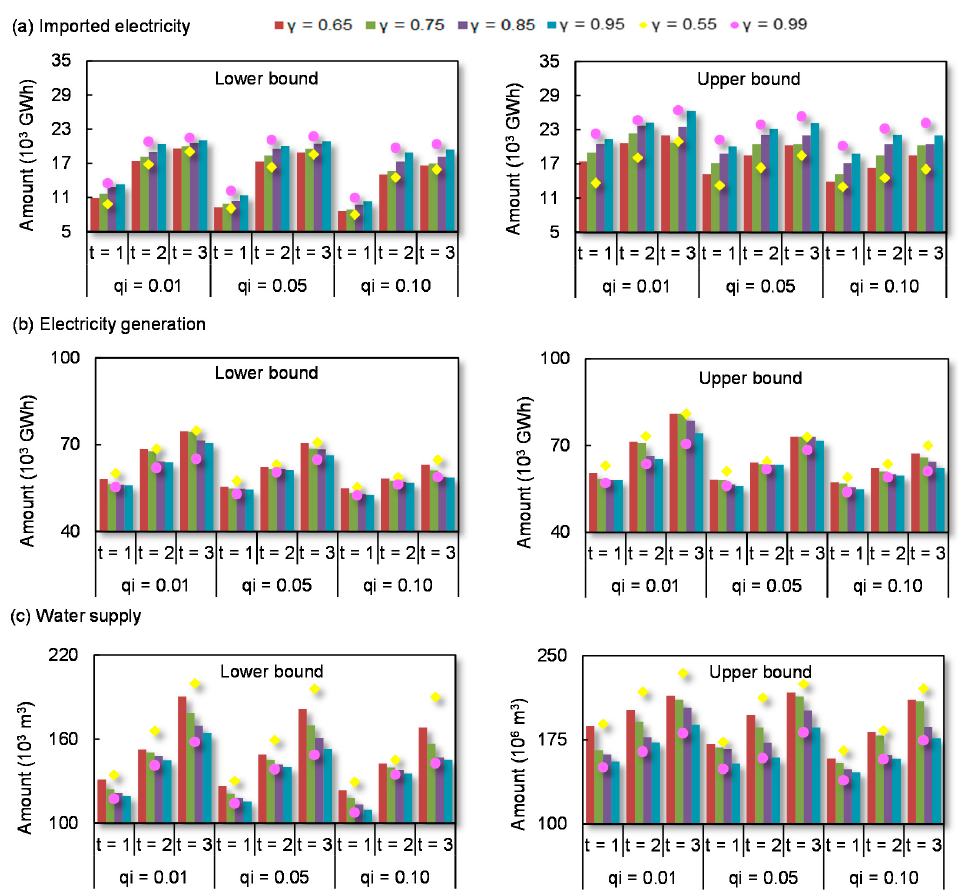
Figure 3. Electricity and water supply patterns under each q i level and γ level: ( a ) imported electricity; ( b ) electricity generation; ( c ) water supply.